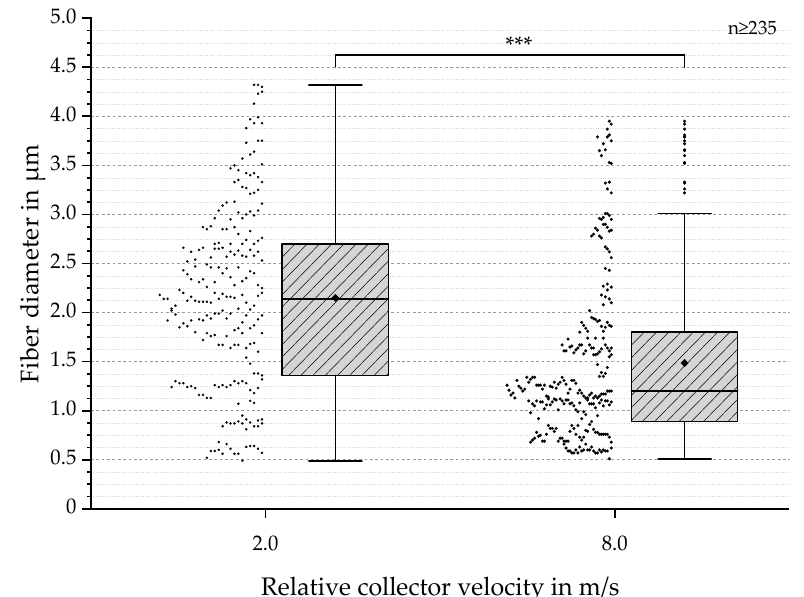
Figure 5. Boxplots with outliers of fiber diameters in µm for relative collector velocities of 2.0 and 8.0 m/s. In addition, individual values are presented as dots on the left side of each boxplot. The datasets show a mean of 2.1 µm for 2.0 m/s and 1.5 µm for 8.0 m/s. Furthermore, the comparison shows a decreased IQR and dispersion for increased relative collector velocity. Based on the QQ Plots, the Mann–Whitney test was conducted and resulted in highly significant differences between the two groups: *** ( p <